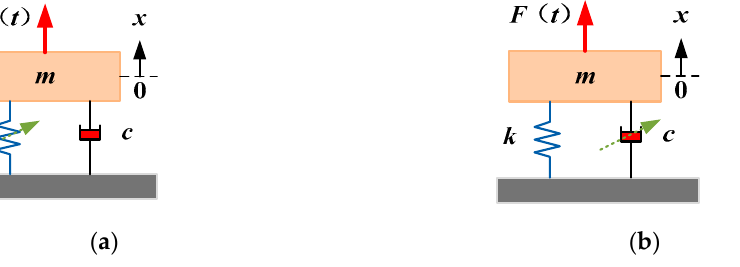
Figure 3. Typical schematic diagram of a semi–active vibration isolation system: ( a ) variable stiffness; ( b ) variable damping.